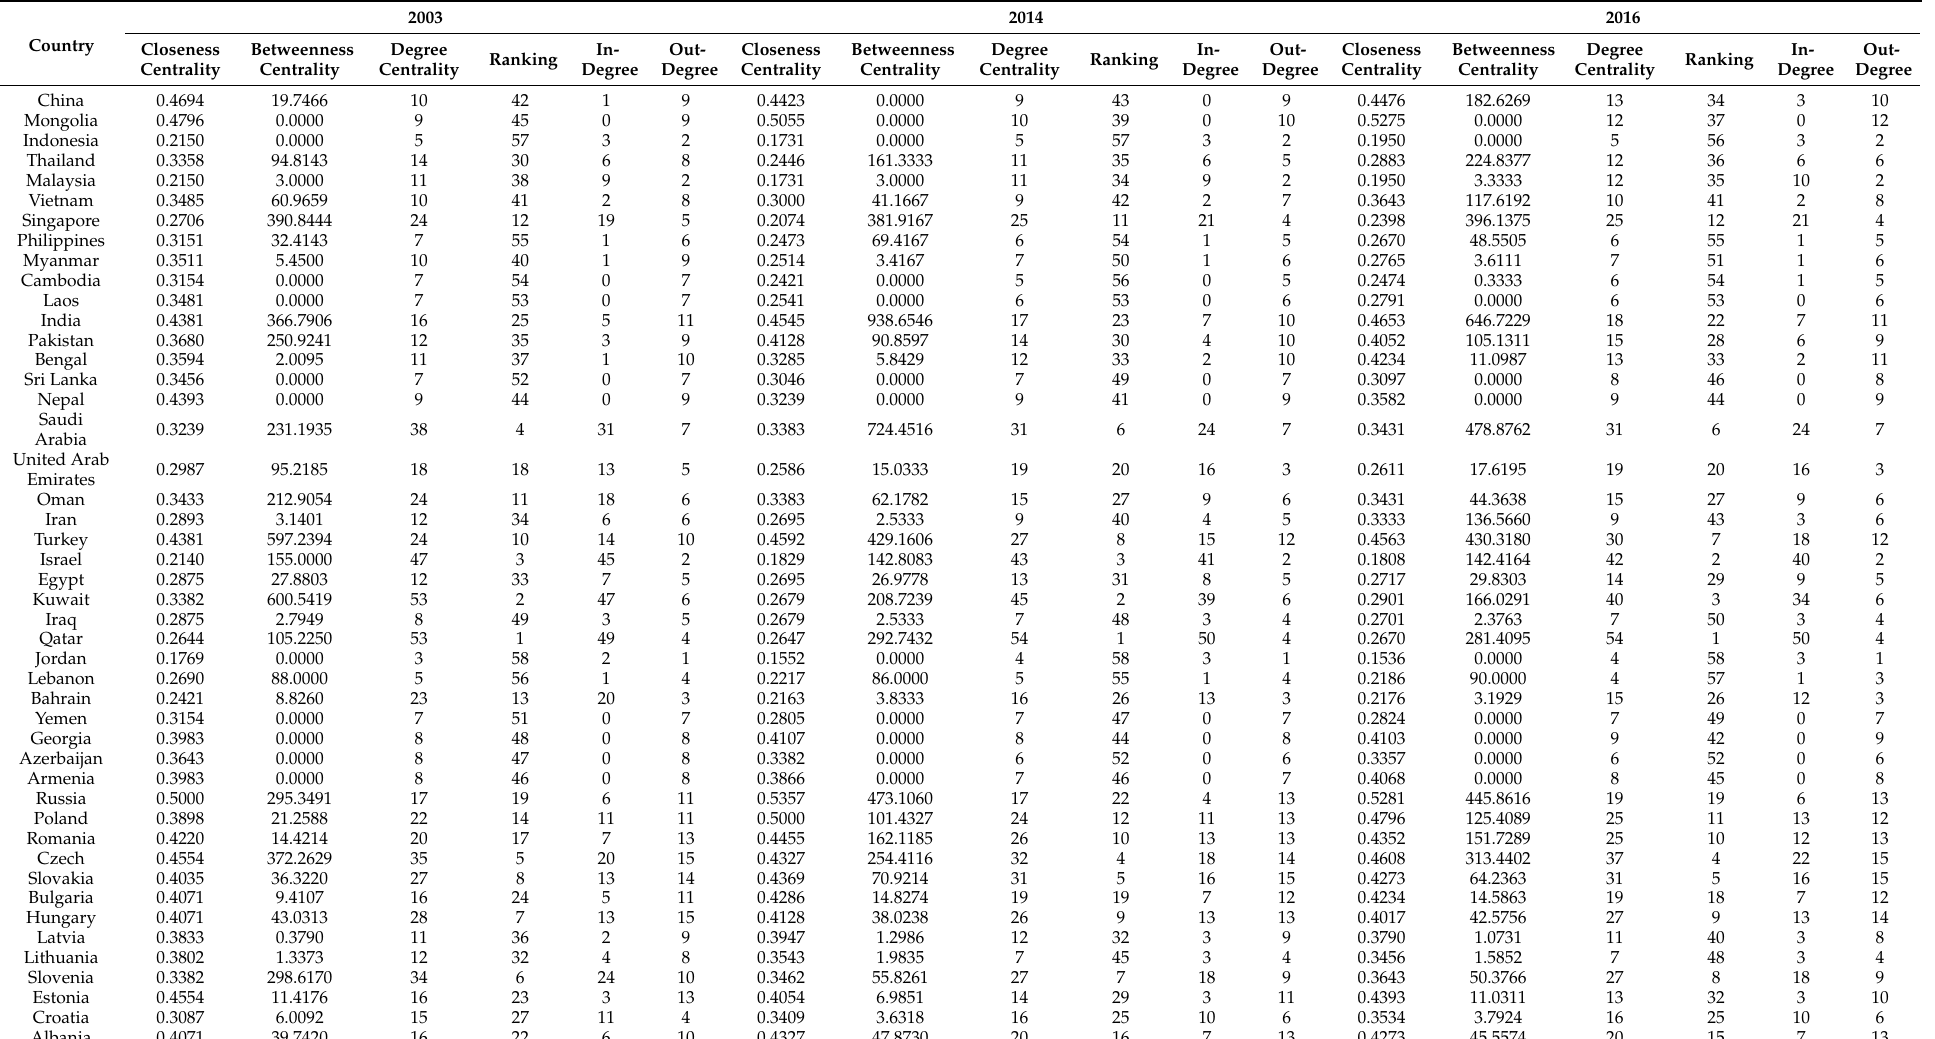
Table 10. Overall characteristics of the energy consumption space network of Belt and Road